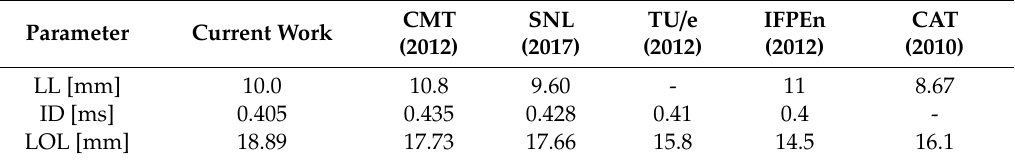
Table 4. Comparison of main spray parameters between database available in the ECN [20] and current work for dodecane under Spray A conditions (900 K, 1500 bar and 15% O 2 ).